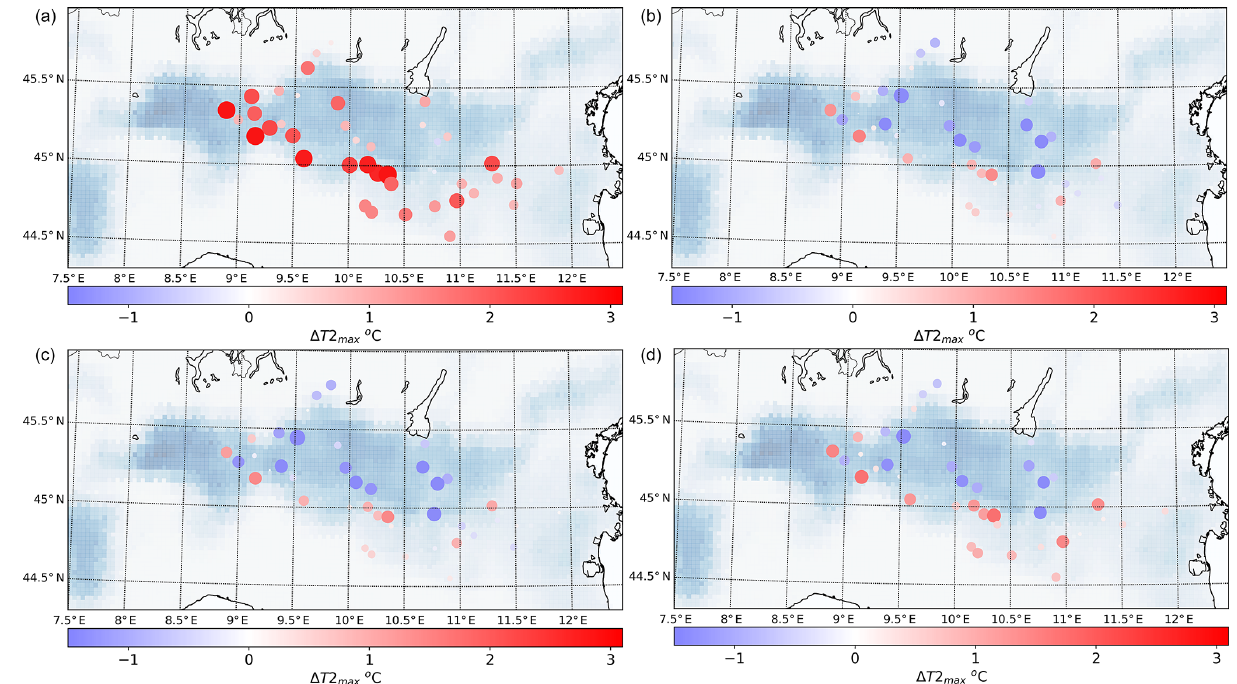
Figure 6. Monthly average for daily maximum 2m temperature difference between model run LR2 and the weather station locations for the